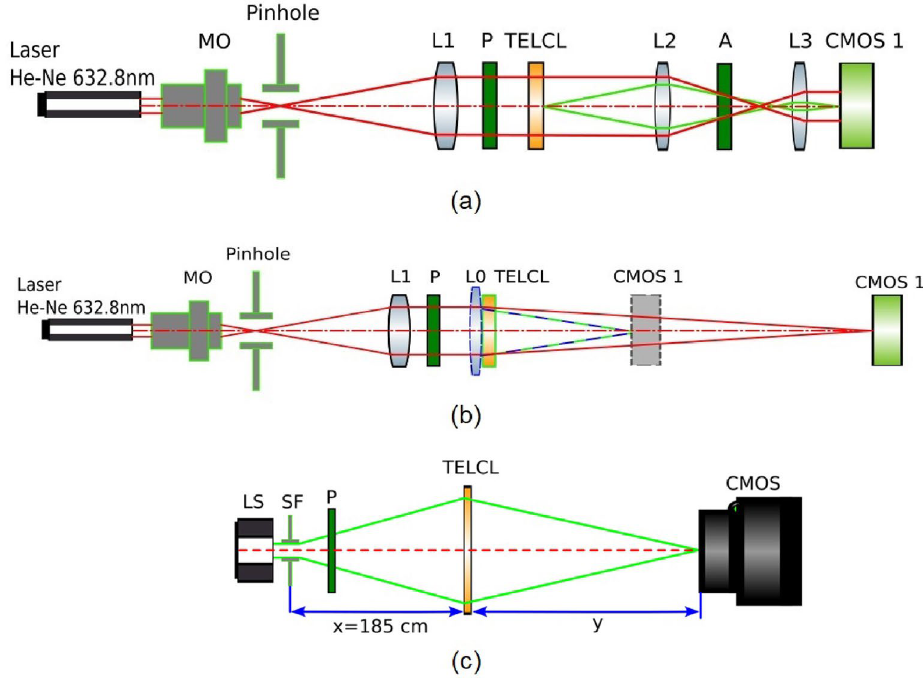
Figure 8. ( a ) Schematic of the optical system for measuring ( a ) the fringe patterns by placing the LC lens between crossed polarizers, ( b ) the focal length of TELCL and ( c ) the MTF function. The figure was generated using Inkscape software with version no. 1 and link https:// inksc ape. org/